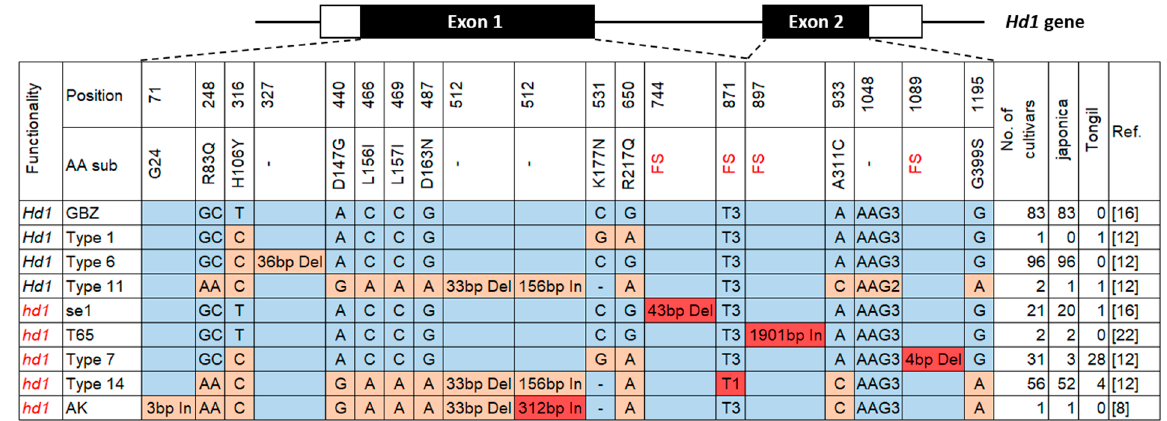
Figure 3. Hd1 allele types in 293 Korean rice cultivars. Hd1 and hd1 indicate functional Hd1 and nonfunctional hd1 alleles, respectively. The positions for the nucleotide polymorphisms are according to the Hd1 gene of the japonica rice cultivar, Ginbouzu (GBZ; GenBank accession AB041840.1). Nucleotide polymorphisms responsible for loss-of-function are highlighted in red. AA—amino acid; FS—frame shift. Table 1. Hd1 allele types of 293 Korean rice cultivars.